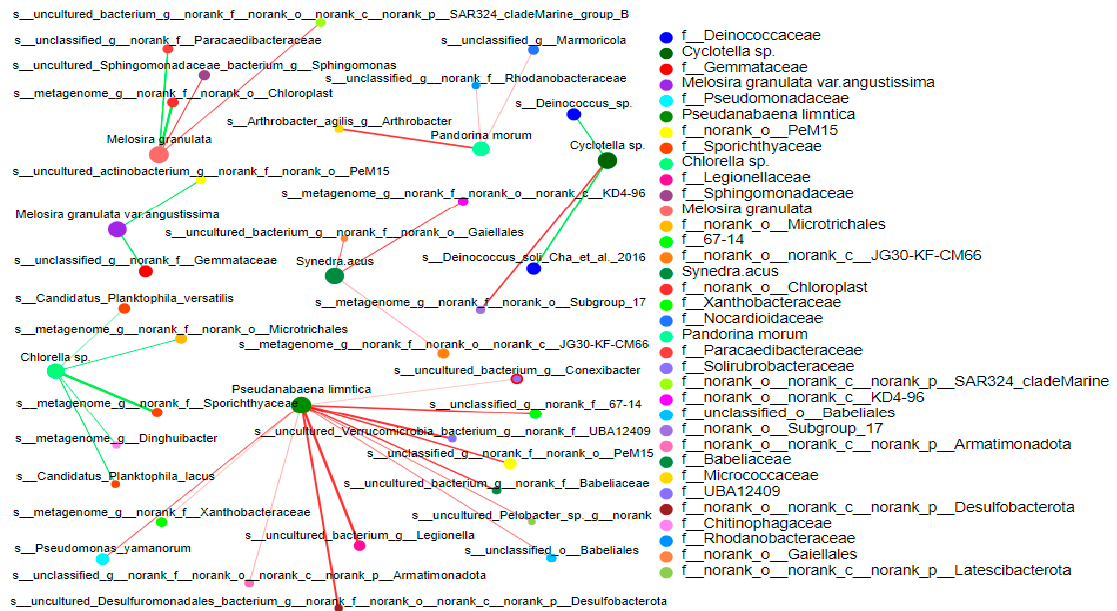
Figure 8. Correlation network analysis between bacterioplankton and phytoplankton. The node size in the figure indicates the species abundance, and different colors indicate different species. The color of the connection indicates positive and negative correlation, red indicates positive correlation, and green indicates negative correlation; the diameter of the line represents the size of the correlation coefficient.